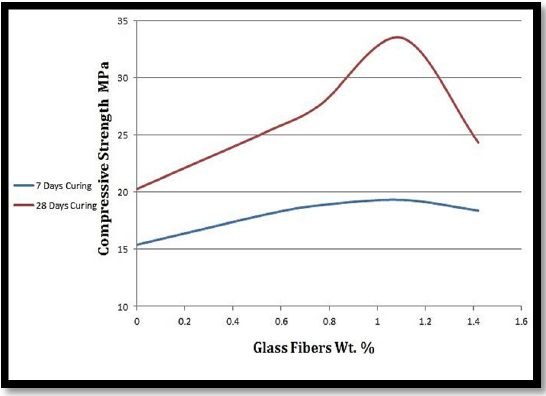
Fig. 9. Effect of glass fibers layers addition on mortar after curing for 7 and 28